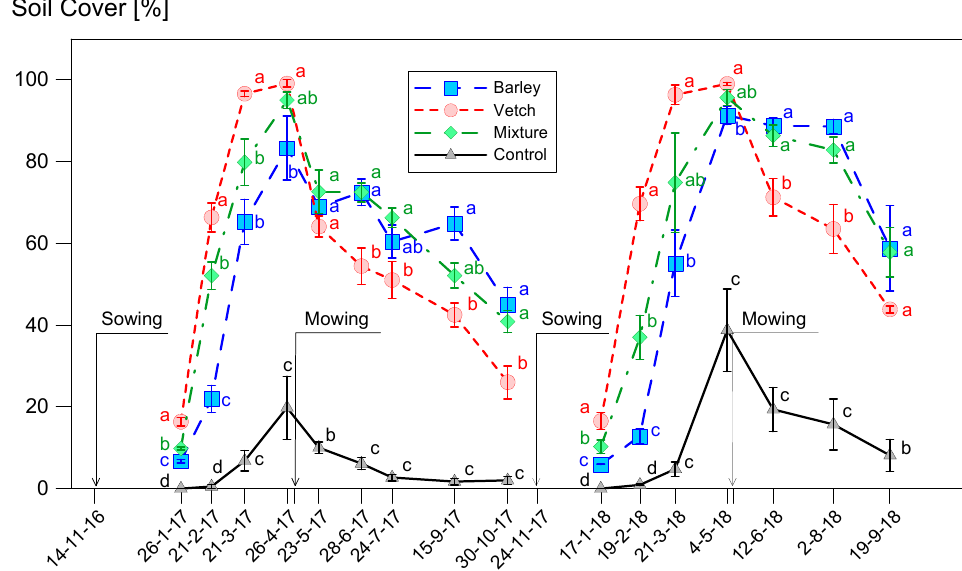
Figure 4. Degree of soil covered by cover crop treatments during the study period. Vertical bars represent standard error. Different letters in each measuring date are statically different based on the Least Significant Difference (LSD) test ( p ≤ 0.05). X units follows the format DD-MM-YY.